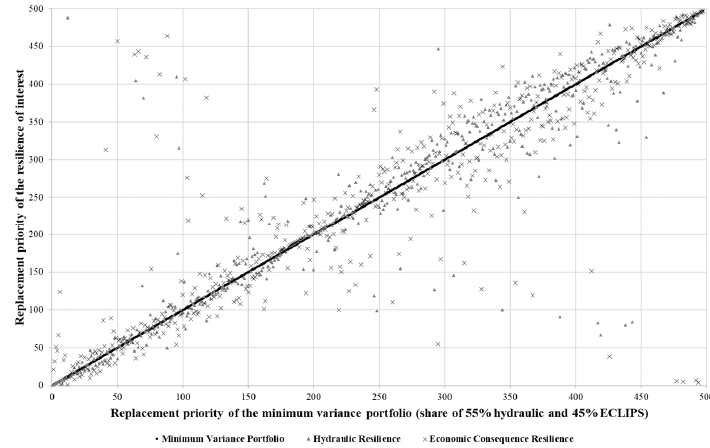
Figure 7. Pipe replacement priority di ff erence to the pipe replacement priority based on the system